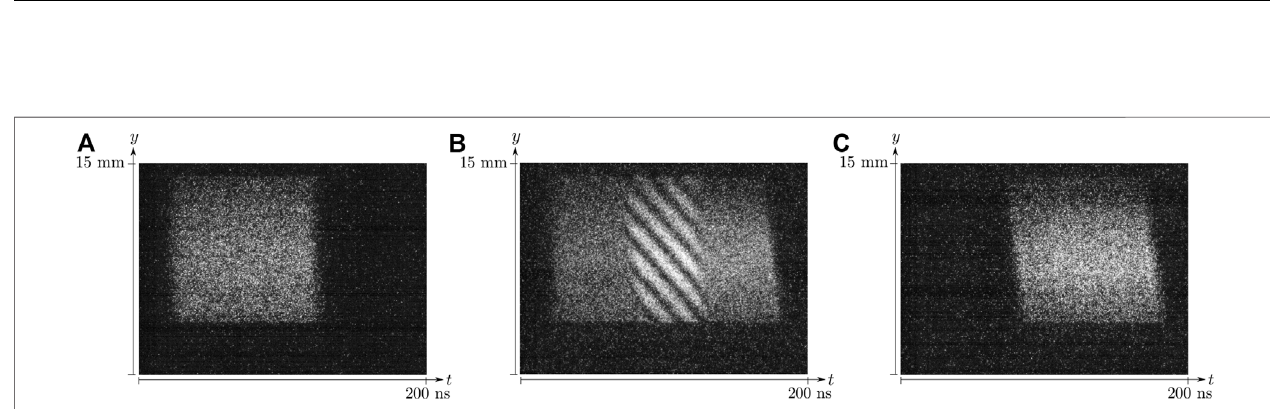
FIGURE 2 | Streak camera images. The abscissa represents time at 10 ns/mm sweep rate with δ t (cid:1) 1 ns temporal resolution. The ordinate depicts the beams transverse distance in the y direction. (A) 97 ns pulse from laser code named oxeb .; (B) Interferogram when both laser pulses are present; (C) 95 ns pulse from laser code named